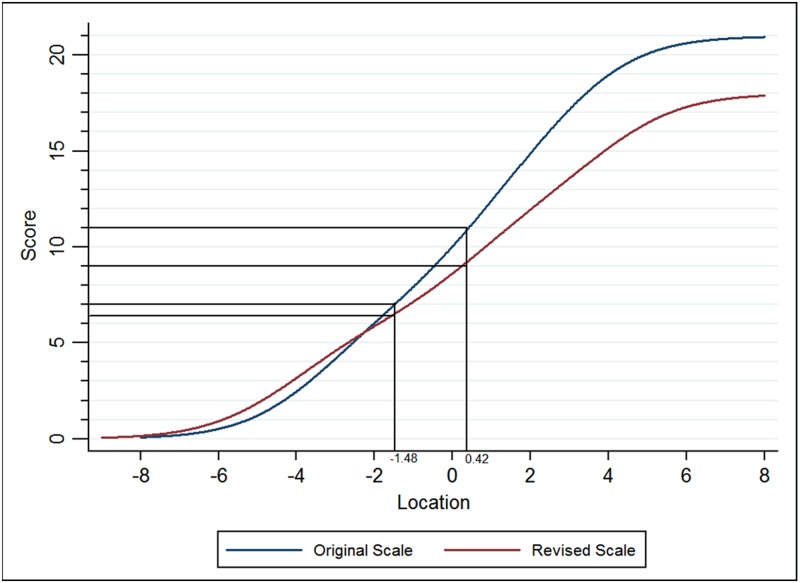
Equating tests to ascertain new cut-off scores for the HADS-A.